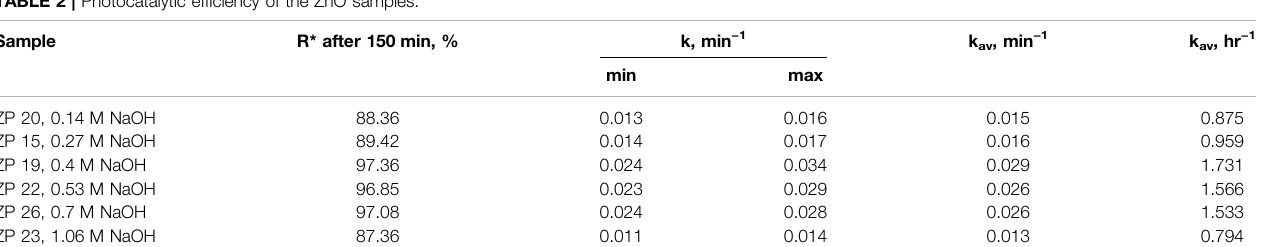
TABLE 2 | Photocatalytic ef fi ciency of the ZnO samples. Sample R* after 150 min, %